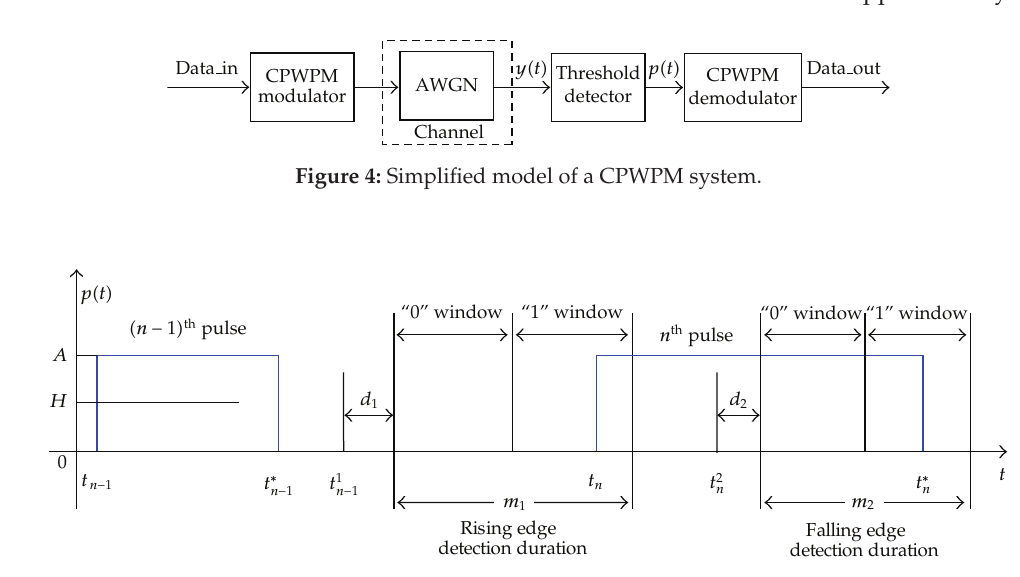
Figure 5: Detection windows of the n th pulse in the CPWPM